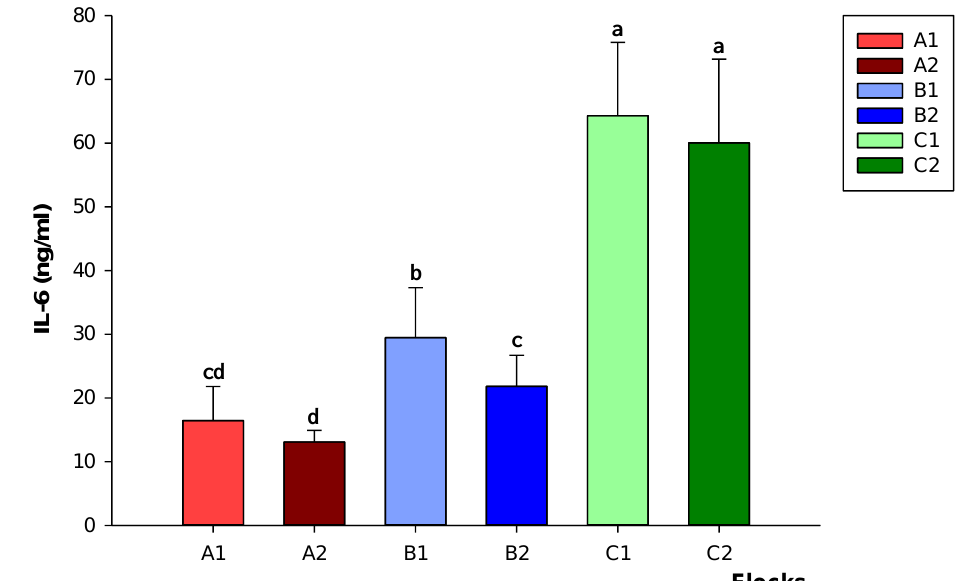
Figure 2. Levels of interleukin-6 (IL-6) in flocks of laying hens housed in enriched cages (A1–A2), barns (B1–B2) and aviaries (C1–C2). Data are reported as means ± standard deviations. Different letters (a–d) indicate significant differences ( p < 0.05) among the different flocks of birds. A similar trend emerged in corticosterone level, with the highest ( p < 0.05) values recorded in laying hens farmed in aviaries (Figure 3). Within the same housing method, significant differences ( p < 0.05) for corticosterone amount were found only between C1 and C2.